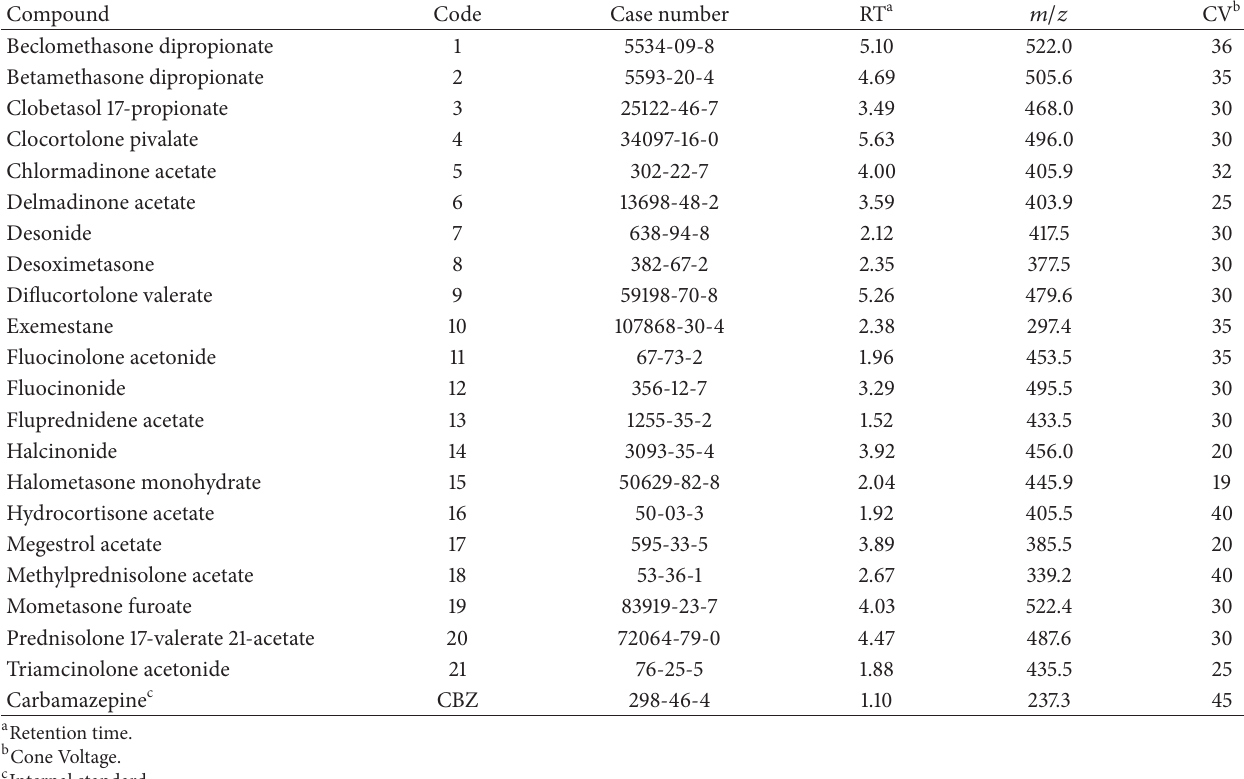
Table 1: Codes and principal chemical features of glucocorticoids.